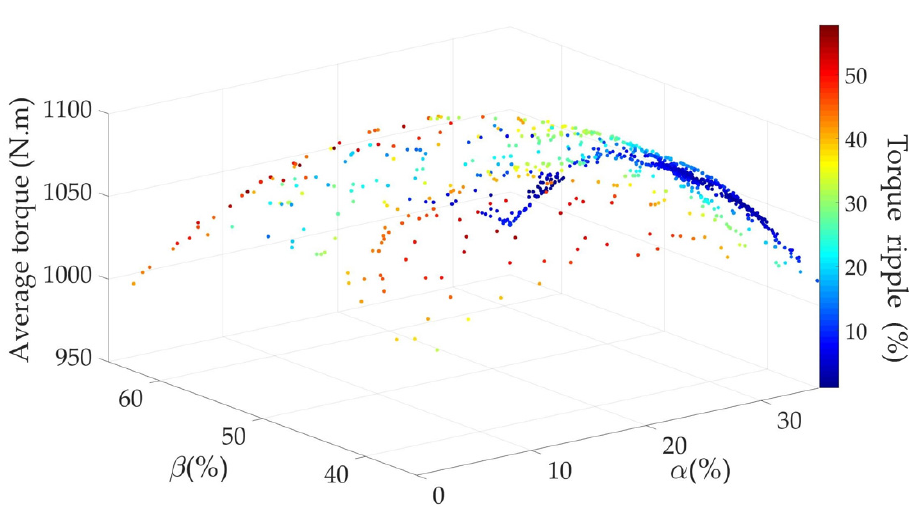
Figure 21. MOGA-based optimization results of the one optimization objective and one constraint.